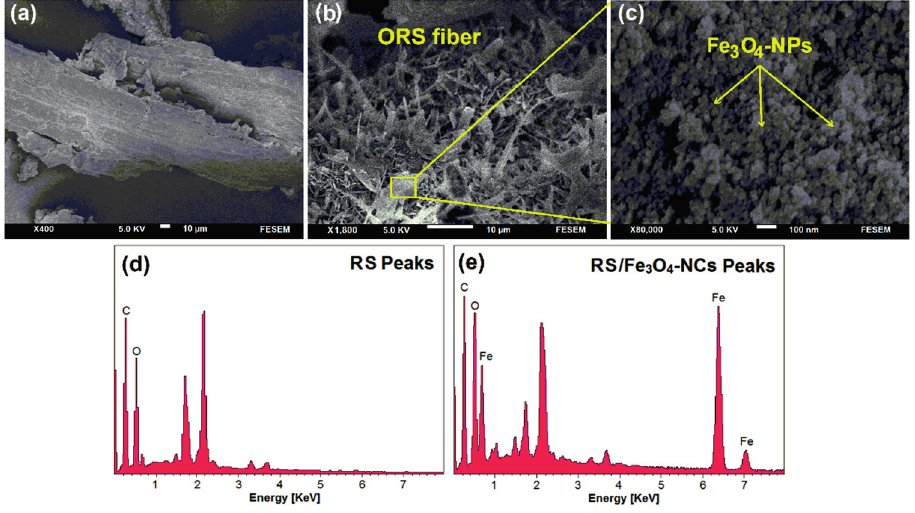
Figure 3. Scanning electron microscopy images of RS ( a ), ORS ( b ), RS/Fe 3 O 4 -NCs ( c ) and energy dispersive X-ray spectroscopy of RS peaks ( d ) and RS/Fe 3 O 4 -NCs peaks ( e ).